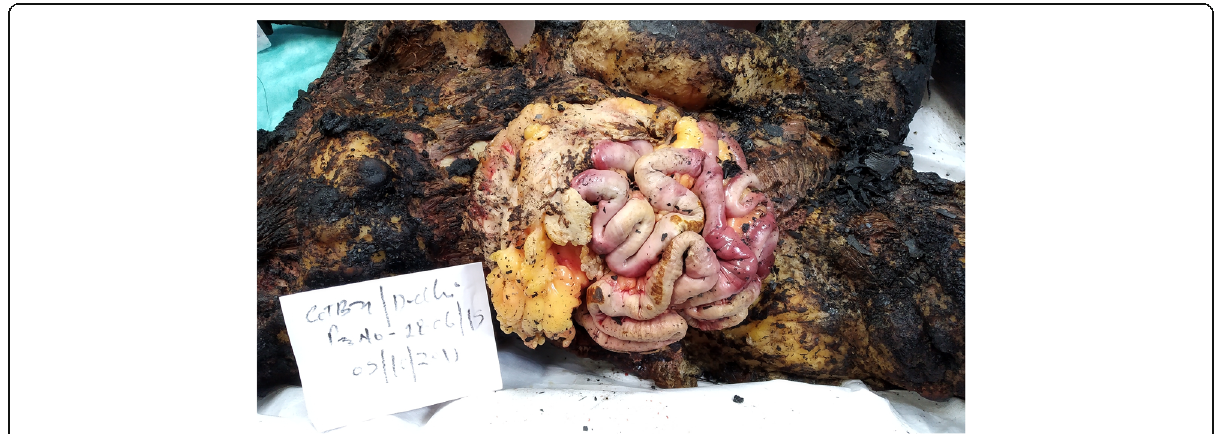
Fig. 4 Intestinal loops protruding out of the abdominal cavity (case